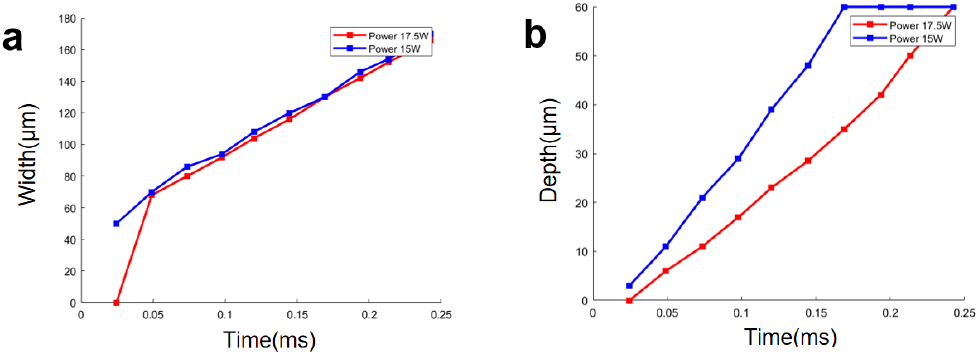
Figure 5. Effect of laser power on the micro hole: ( a ) width; ( b ) depth.